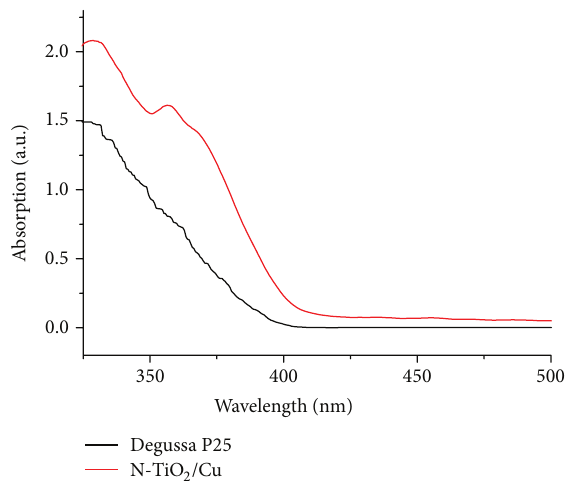
Figure 2: Absorption of TiO 2 and N-TiO 2 /Cu obtained from diffuse reflectance measurements using the Kubelka-Munk